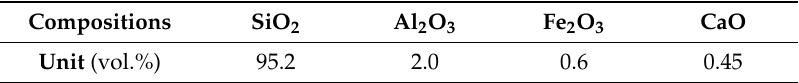
Table 3. Chemical composition of the natural quartz sand.